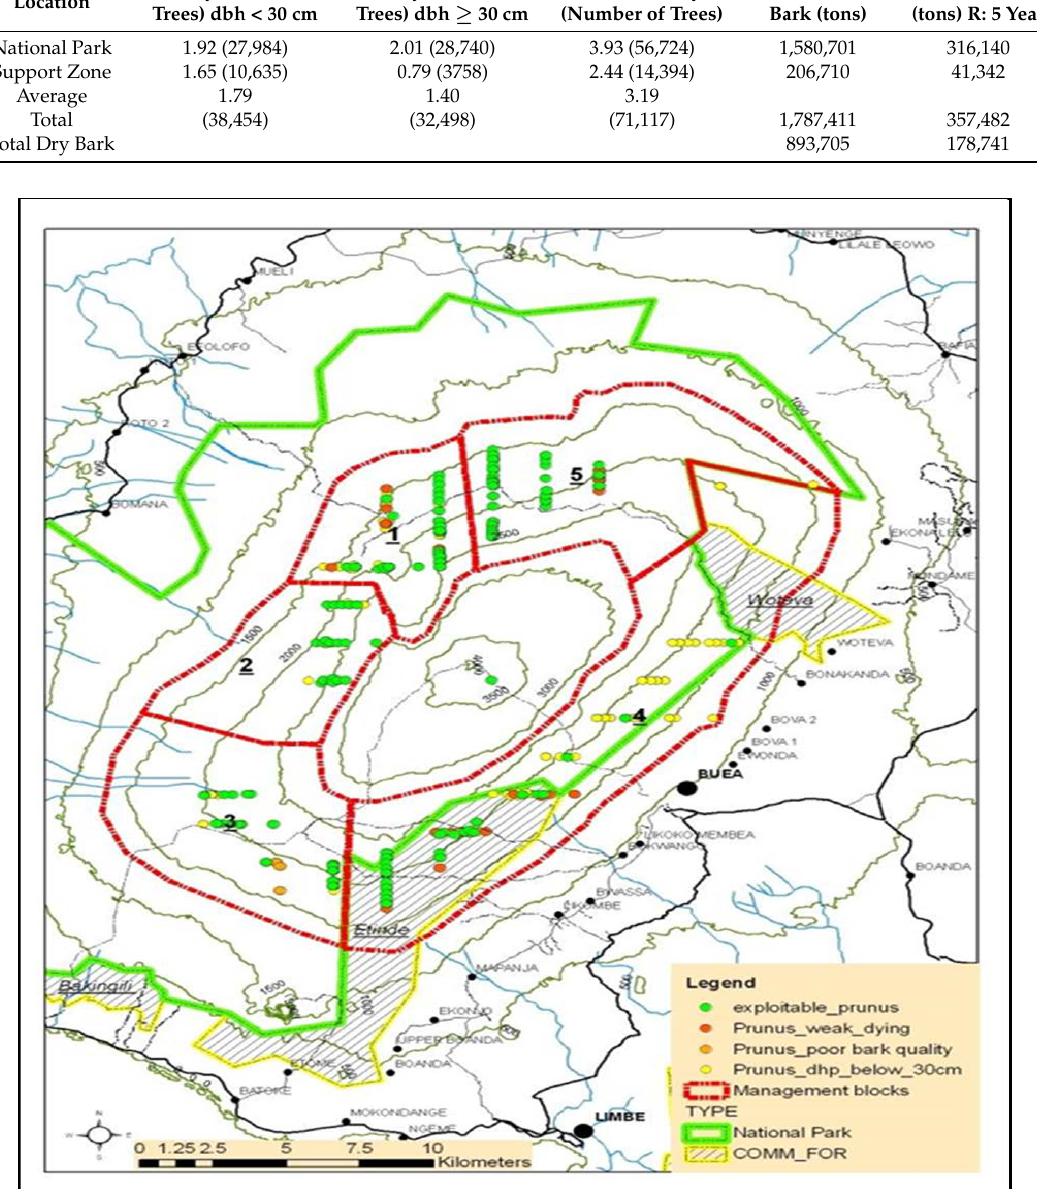
Figure 2. Map of Prunus management clusters as a sub-set of the MCNP management unit showing the distribution of trees [17]. COMM_FOR: Community